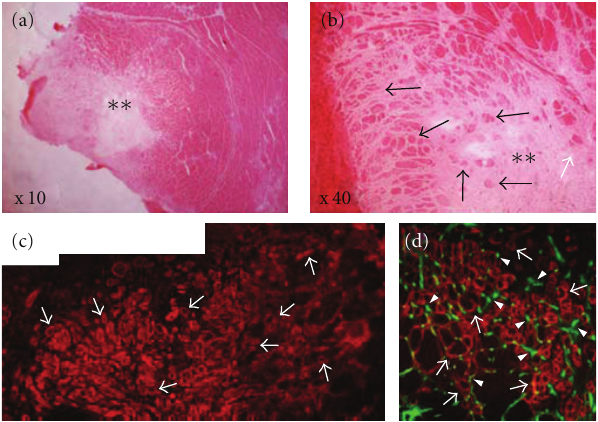
Figure 7: Three months after implantation, evaluation of the regenerative capacity of the seeded sca ff olds. A hematoxylin and eosin staining revealed a large area of fibrosis in the muscle graft ((a) and (b) , sk ). However, within the muscle graft despite the area of fibrosis, we detected regenerating myofibers ((b), arrows f), and large quantities of dystrophin-positive myofibers ((c), arrows f). Within the areas of regeneration, revascularization was detected through the visualization of CD31-positive cells ((d) green/arrows